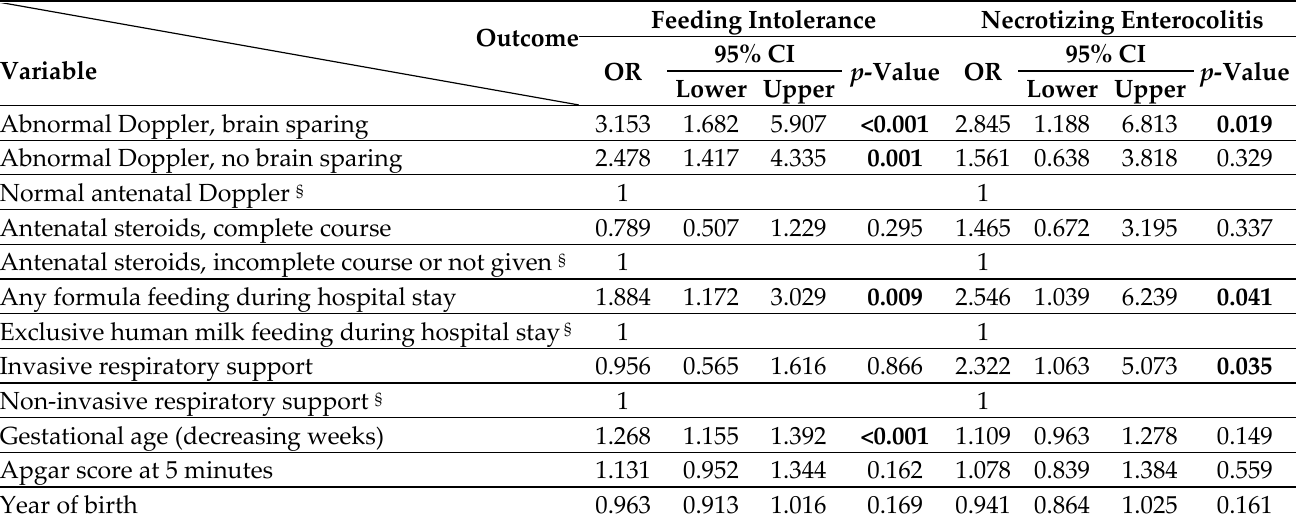
Table 6. Results of the generalized linear models for outcomes that were significantly associated with the presence of brain sparing in the univariate analysis. When the independent variable is categorical, one group is used as the reference category (§). Significant p -values are highlighted in bold. Abbreviations: CI, confidence interval; OR, odds ratio.